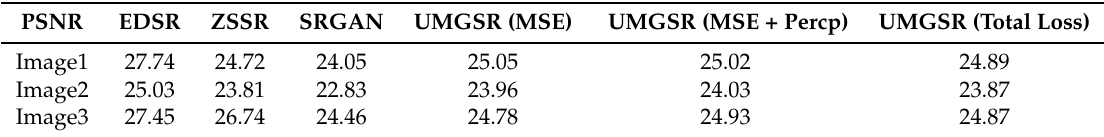
Table 1. Comparison on different methods with DIV2K dataset. The image is 4 × scaled and no cropping is used during the test period. We report the PSNR scores.